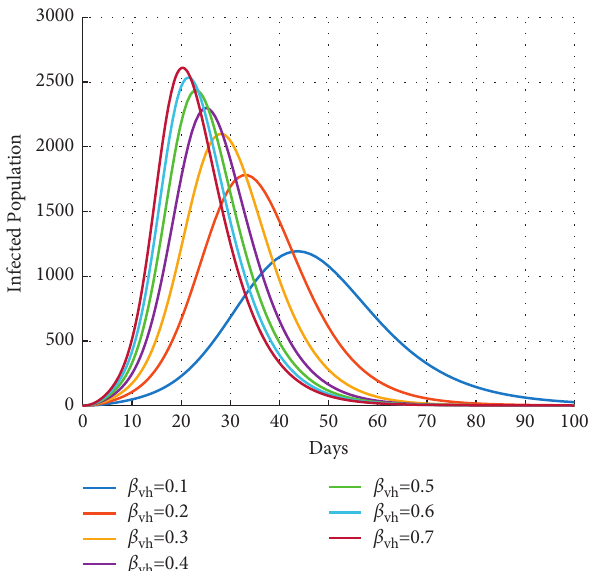
Figure 7: Evolution of the epidemic spreading in the vector population for various values of the vector-to-host transmission rate β vh .